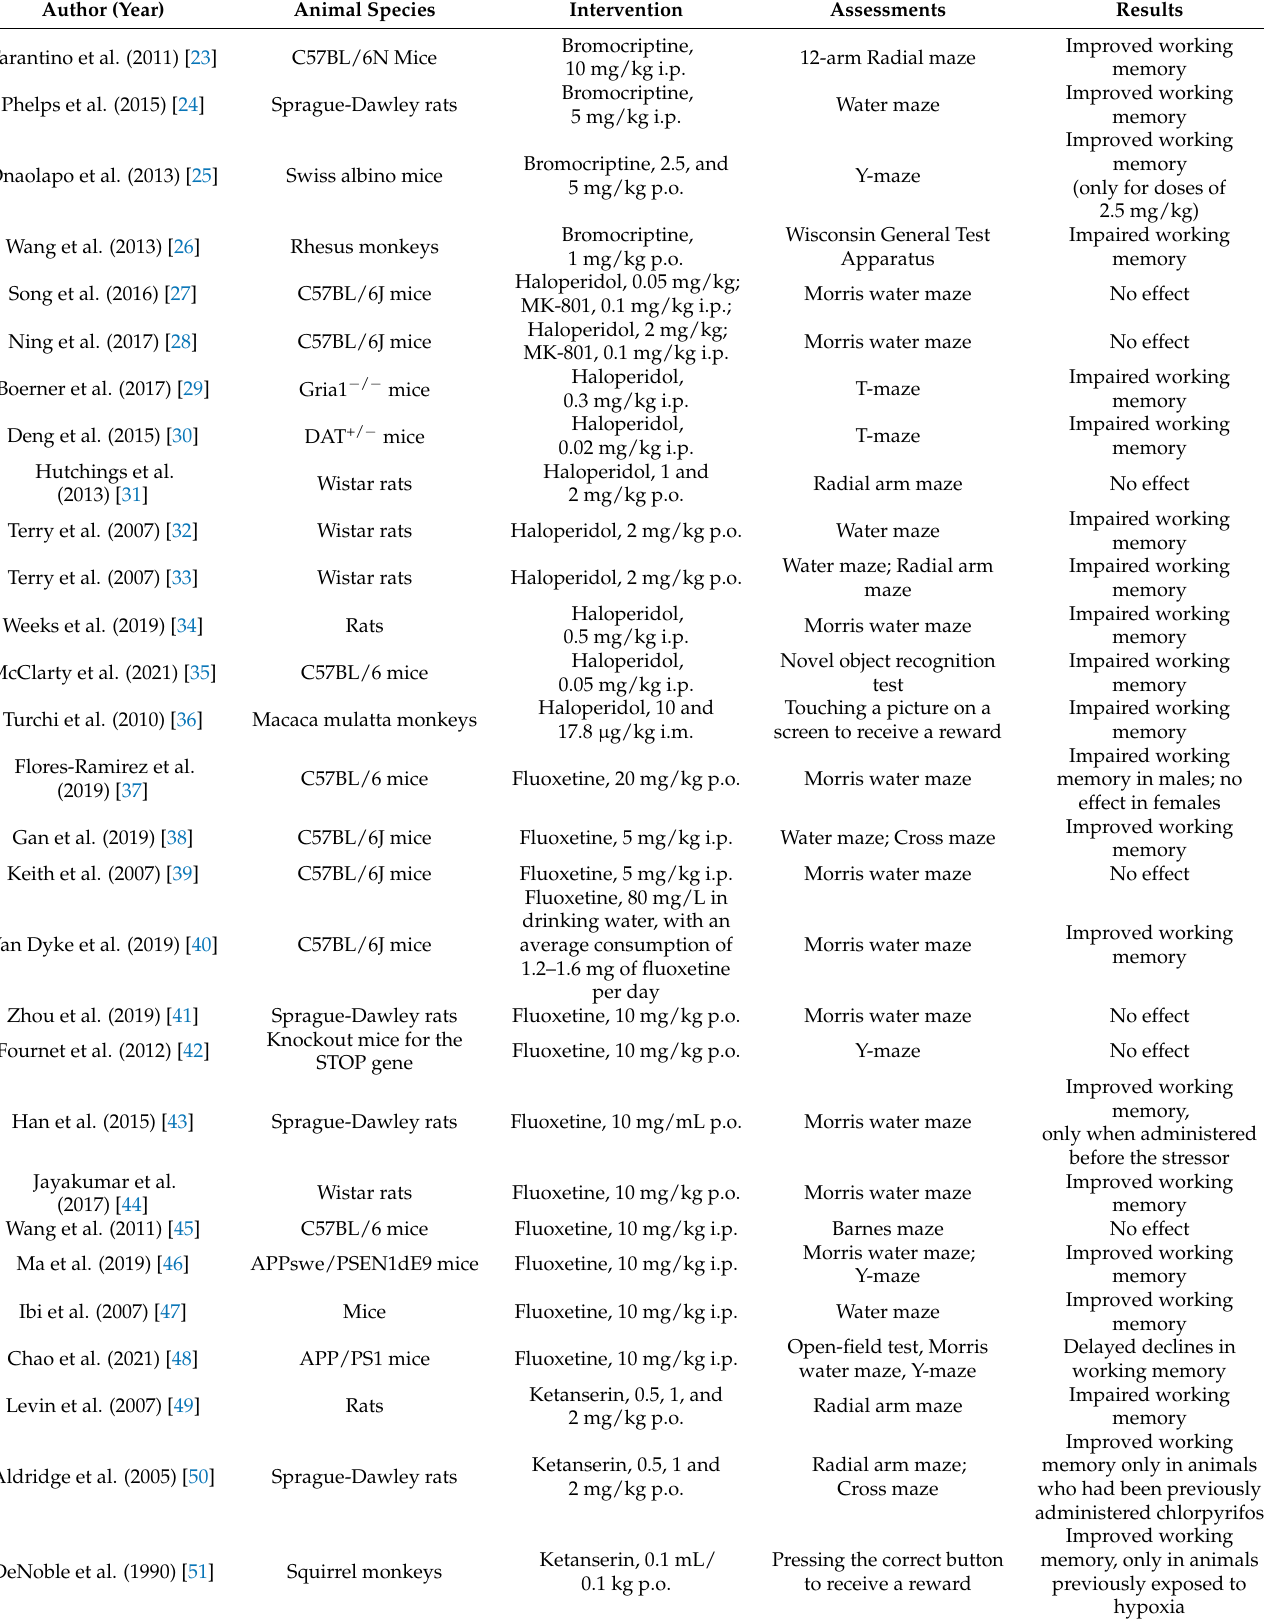
Table 1. Summary table of the articles selected and included in the